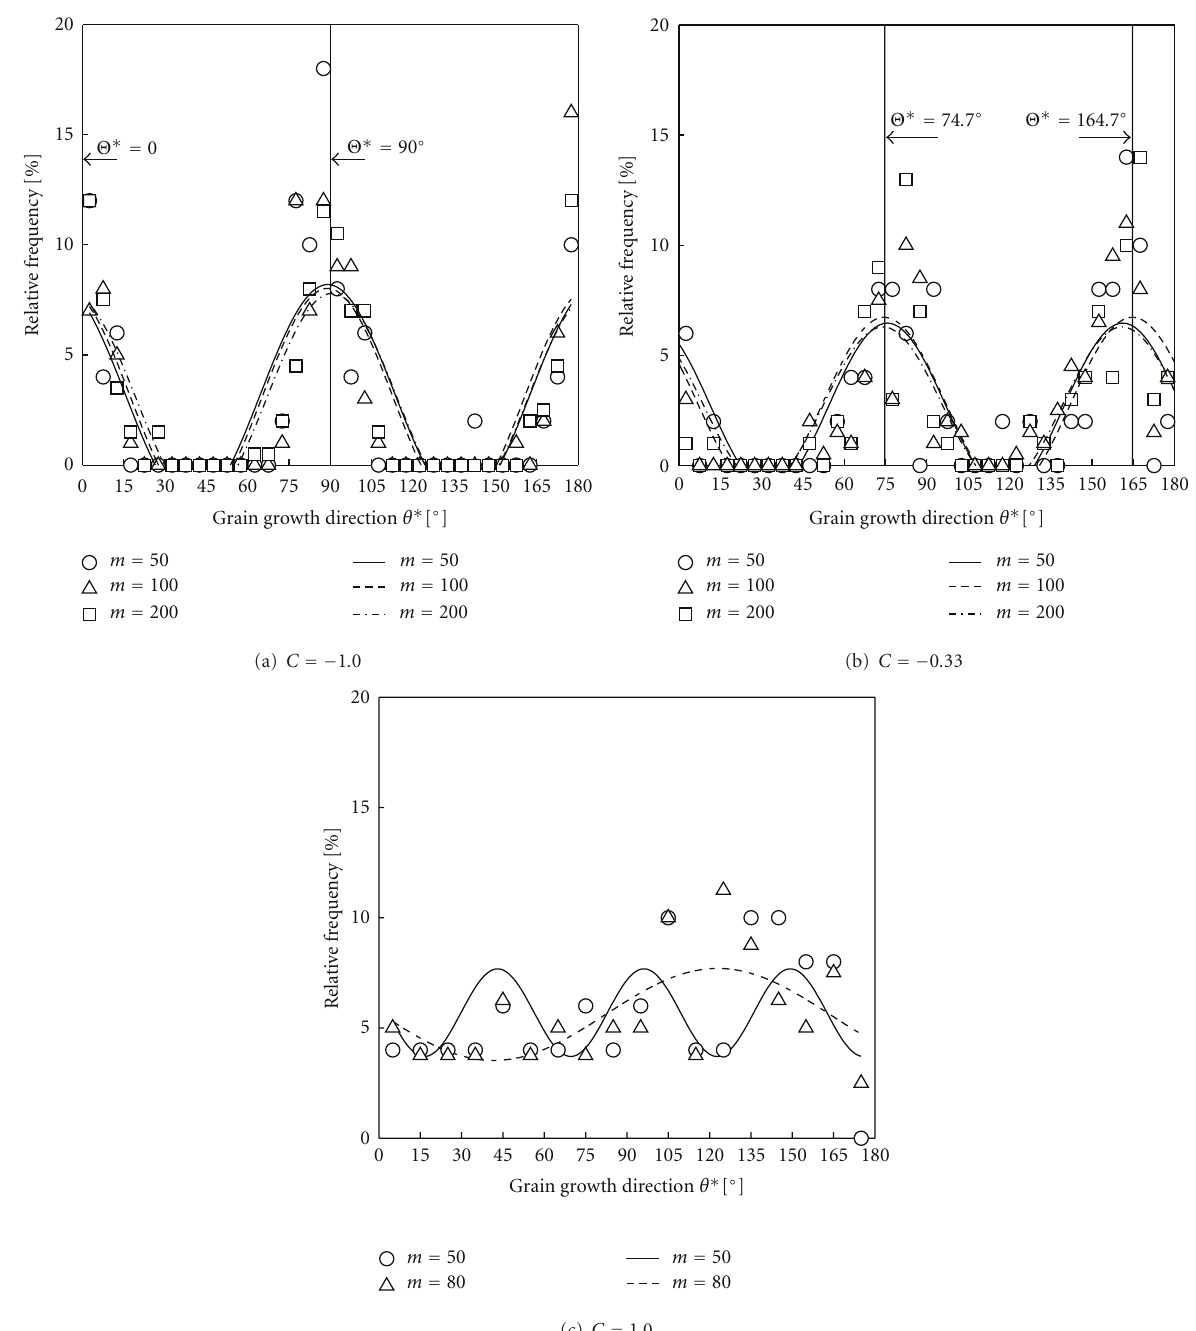
Figure 9: Relative frequency distribution diagram of θ ∗